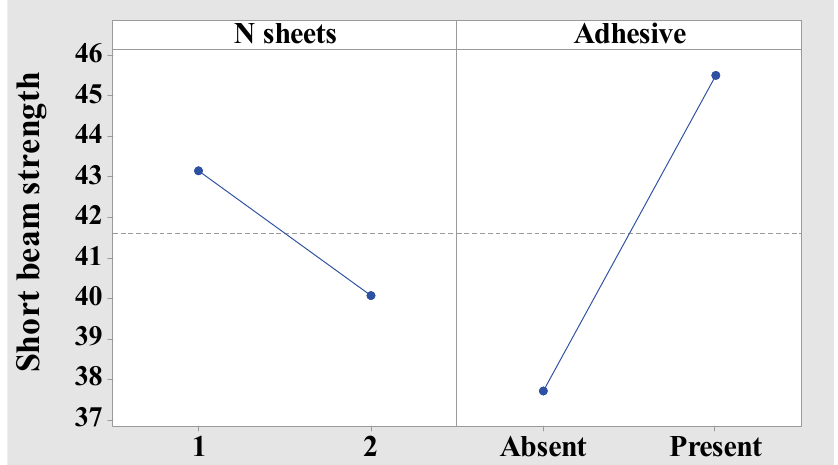
Figure 4: Main effect plot relevant to experimental tests.